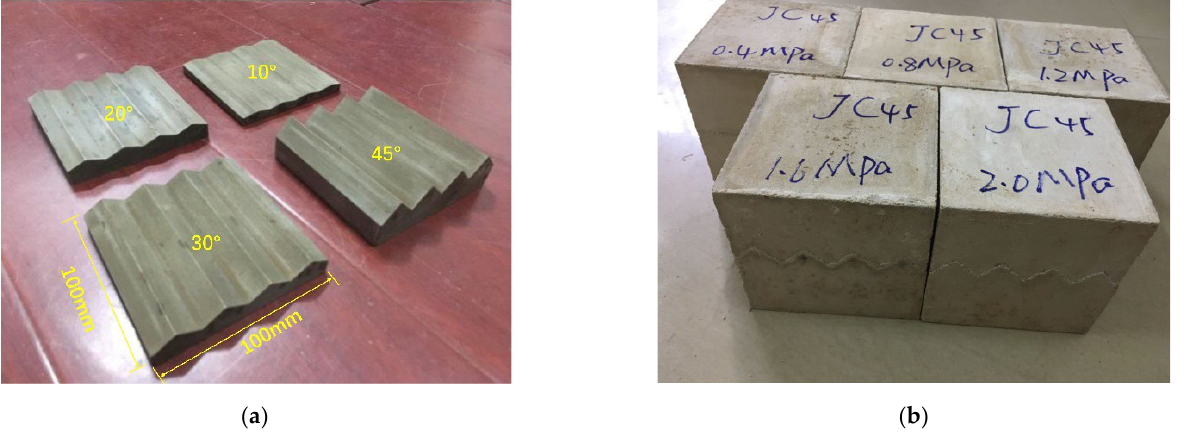
Figure 2. Test specimens. ( a ) Lower test block of joints; ( b ) Prepared specimens.